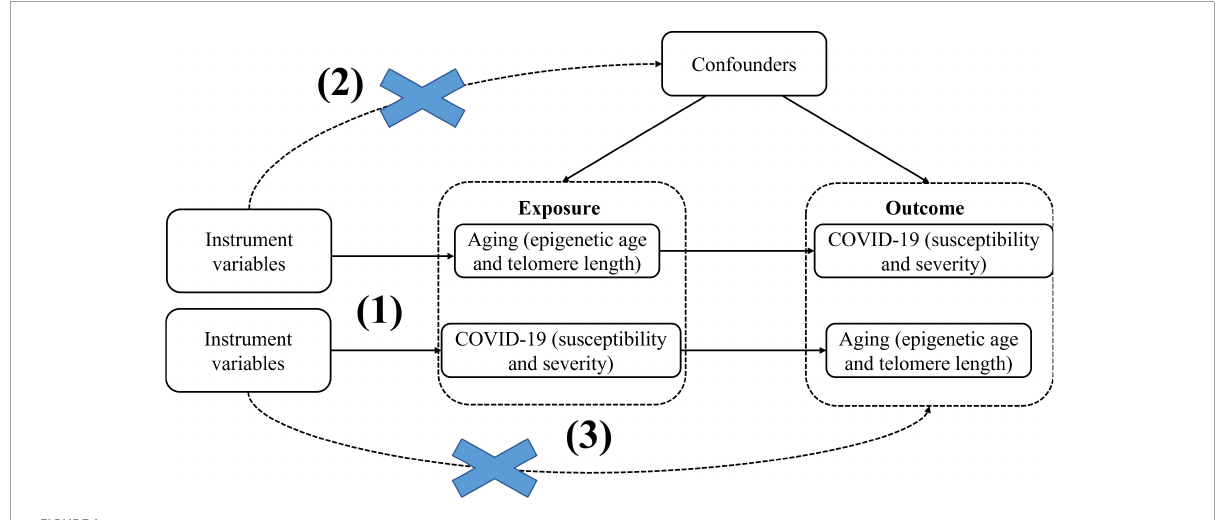
FIGURE1 BidirectionalMendelian randomization paradigm and assumptions of aging and COVID-19. Mendelian randomization assumptions: (1)the instrument variants must be closely related to the exposure, (2) the instrument variants must be independent of any confounder of the exposure-outcome association, (3) the instrument variants must be associated with the outcome only via the